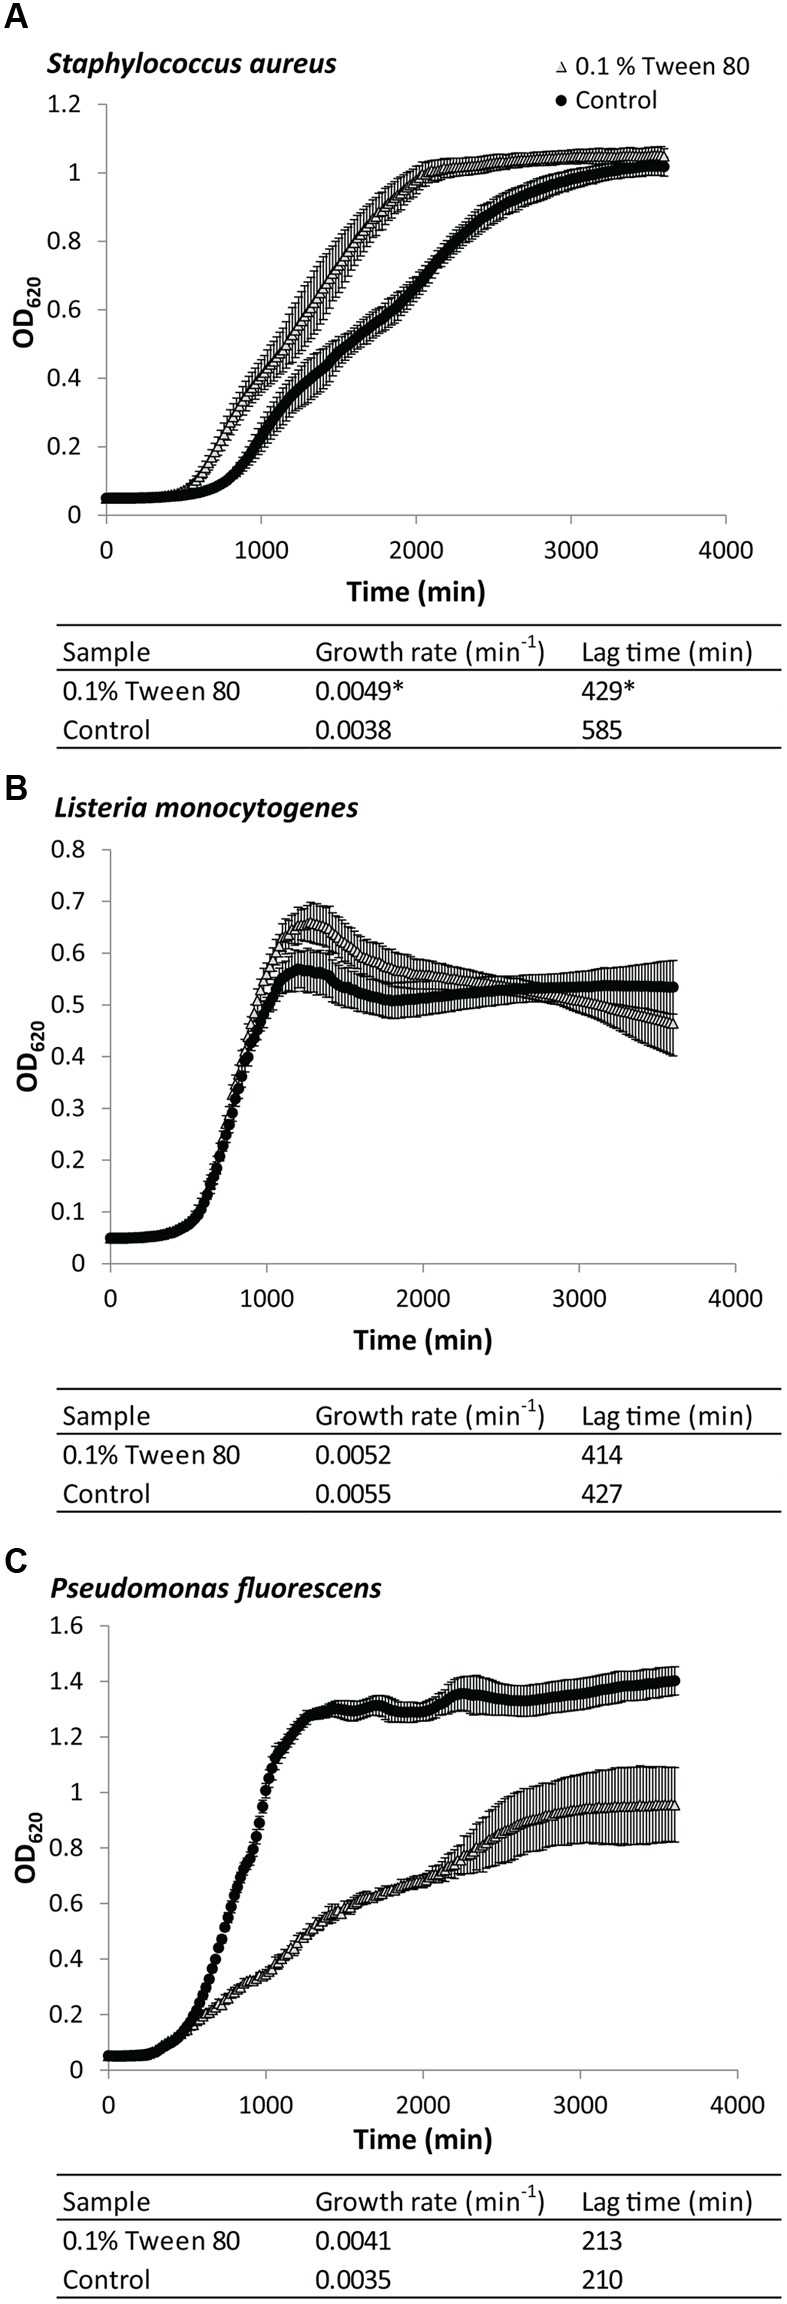
Growth curves of (A)
Staphylococcus aureus, (B)
Pseudomonas fluorescens, or (C)
Listeria monocytogenes grown in either Tryptic Soy Broth (TSB) or TSB with 0.1 (v/v) % Tween 80. Error bars show standard deviation of the mean (n = 9). Growth rates and lag times are included. Statistical significance compared to control is marked by ∗(p < 0.05).